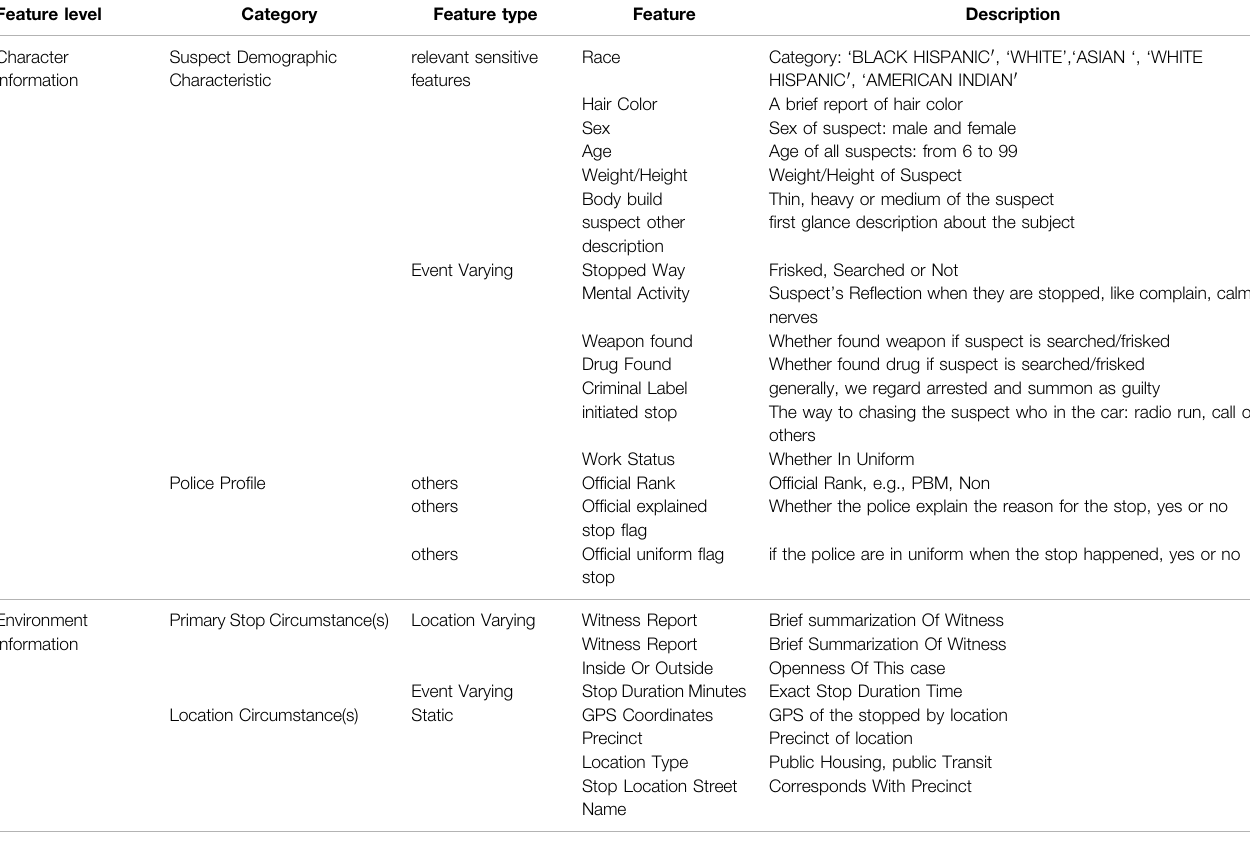
TABLE 1 | Summary of key information recorded on the UF-250 Stop-and-Frisk form. Feature